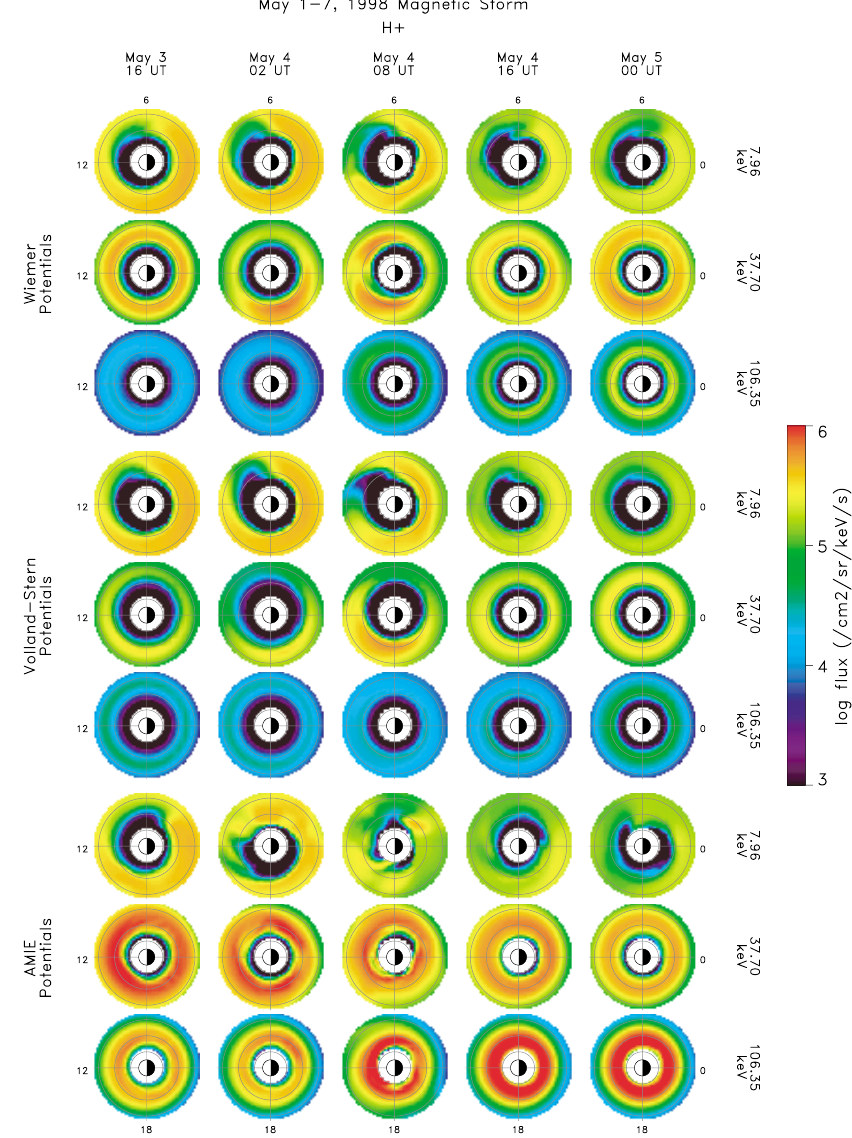
Fig. 9. Pitch-angle averaged H + differential number flux at 5 times during the storm (columns). For each of the 3 electric potential descriptions (sets of rows), 3 energies are shown (rows in each set). Each plot extends to 6.6 R E , with gray circles drawn every 2 R E . Local noon is to the left and dawn is to the top in each